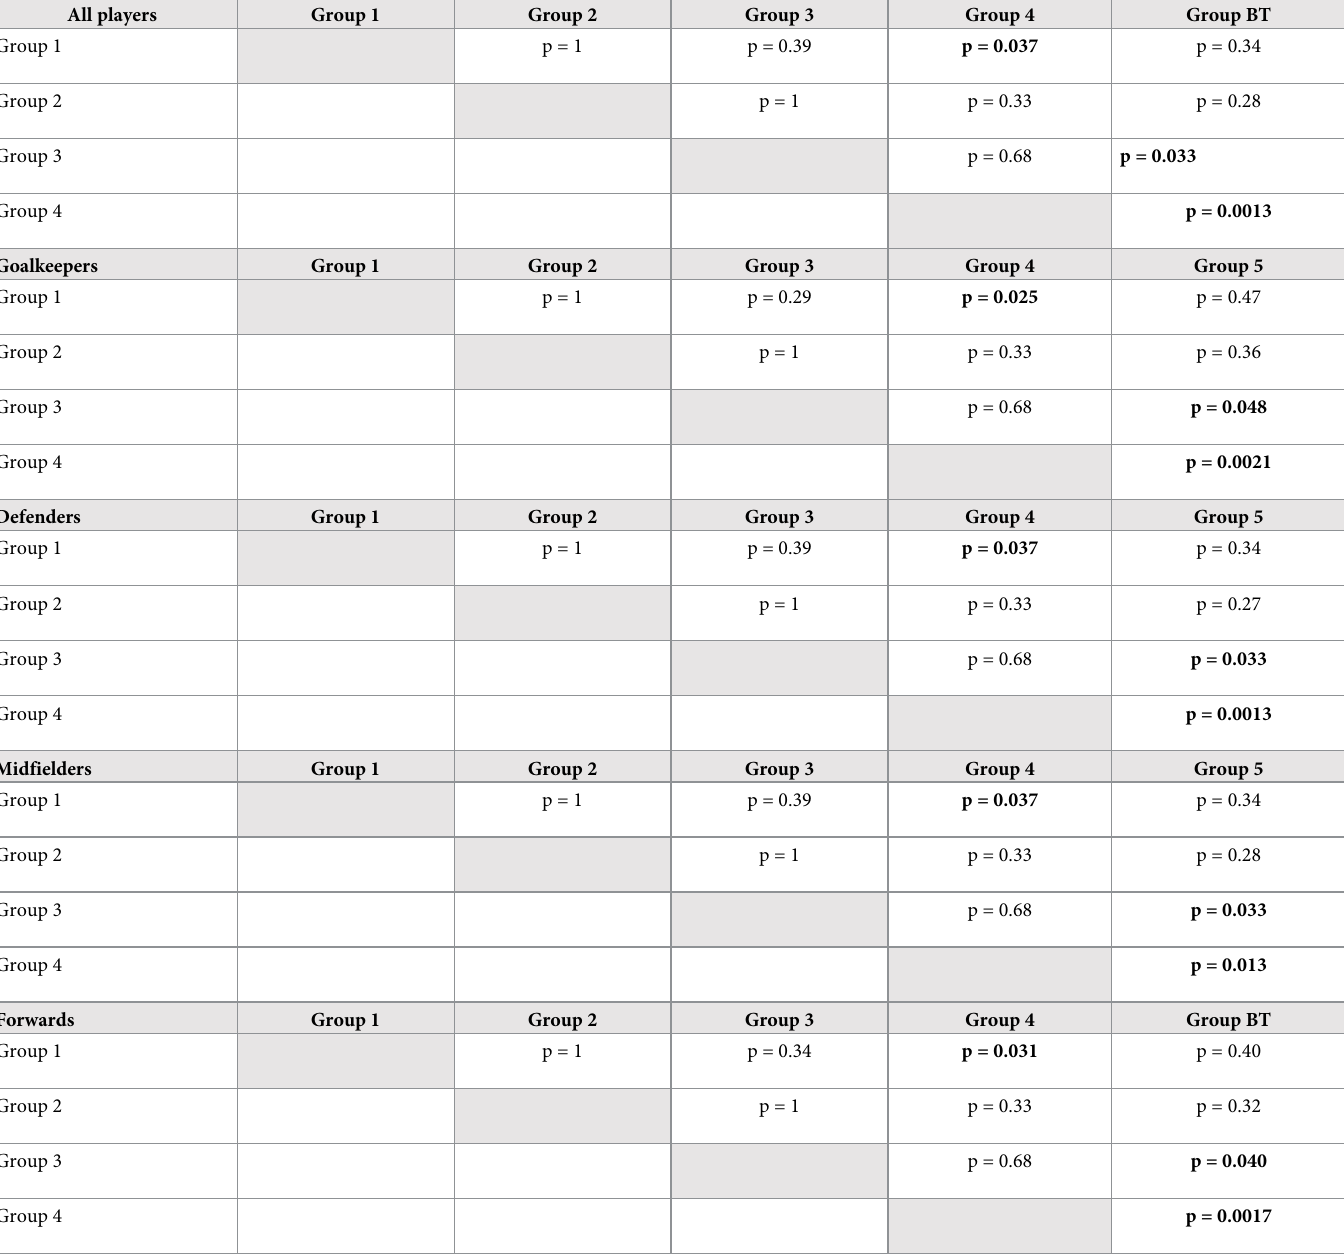
Table 7. Differences between market value between groups (p values)—Dunn test with Holm